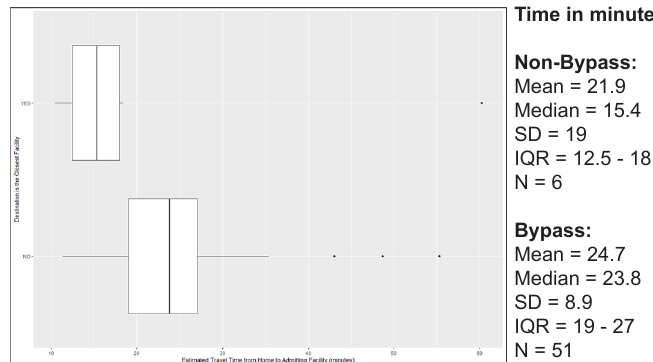
Figure 5. Estimated travel time from home to facility among admitted patients with home address (N = 57). Box and whisker plots represent median (middle line), IQR (borders of box from 25th (Q1) to 75th (Q3) percentiles), edges of lines represent values within Q1–1.5*IQR to Q3+1.5*IQR; isolated dots represent outliers beyond the ±1.5*IQR values. SD , standard deviation; IQR , interquartile